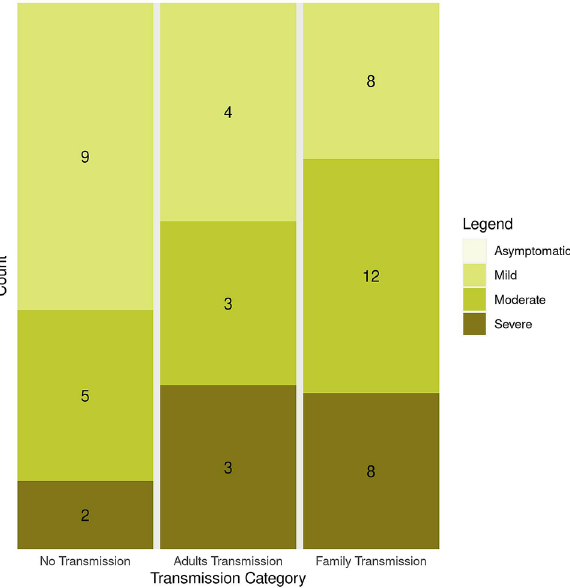
Figure 2. Symptom severity of COVID-19 index cases in the households. The GLM (generalized linear model) revealed that there were less individuals in the "Severe" category than in the "Mild" category ( p = 0.1), and that households in "Family transmission" category was overrepresented in the "Severe" category ( p = 0.03). There were no asymptomatic index cases. Maximum severity score of index is used.